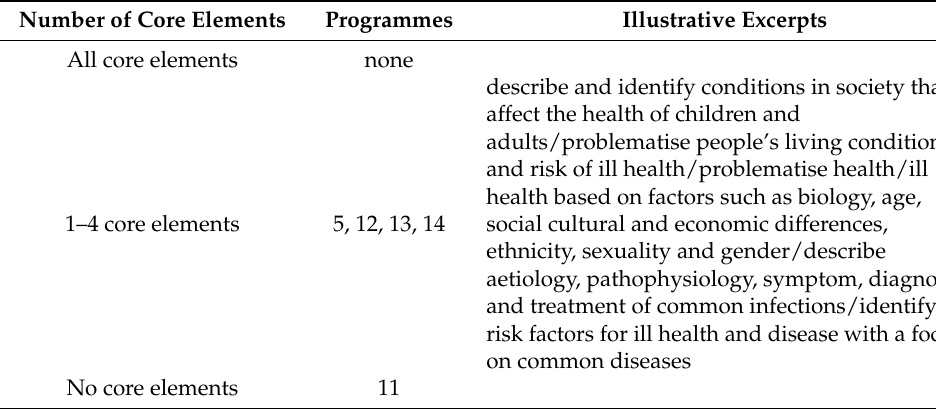
Table 4. Syllabi grouped under the theme Health